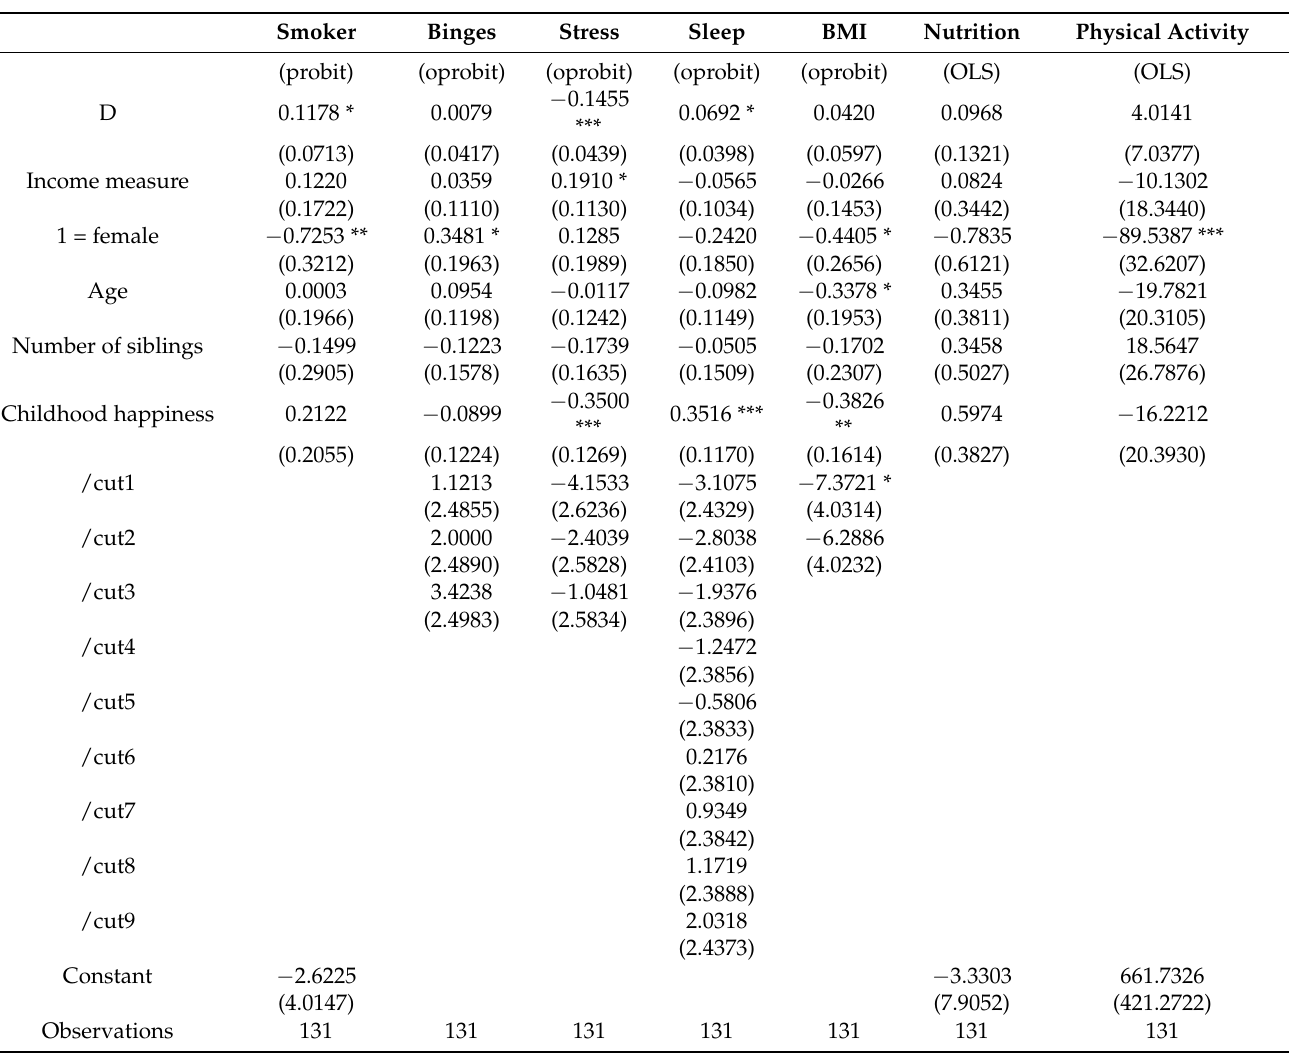
Table A3. Regressions with only basic background control variables.